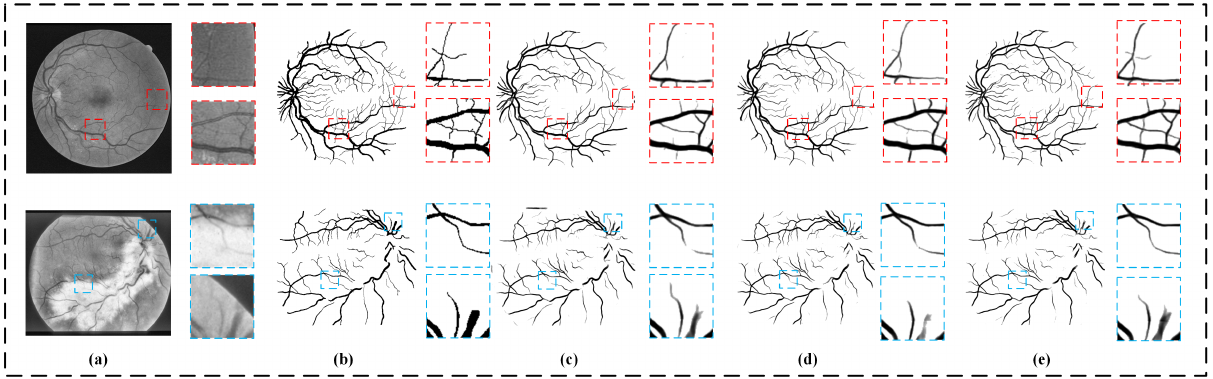
Figure 9. The model segmentation results of different self-attention modules integrated. The top row is the based on DRIVE dataset, and the bottom row is the STARE dataset. ( a ) The original image, ( b ) the ground truth, ( c ) the segmentation result of Basenet, ( d ) the segmentation result of the integrated SW module and ( e ) the segmentation result of the our model integrated with the GSA